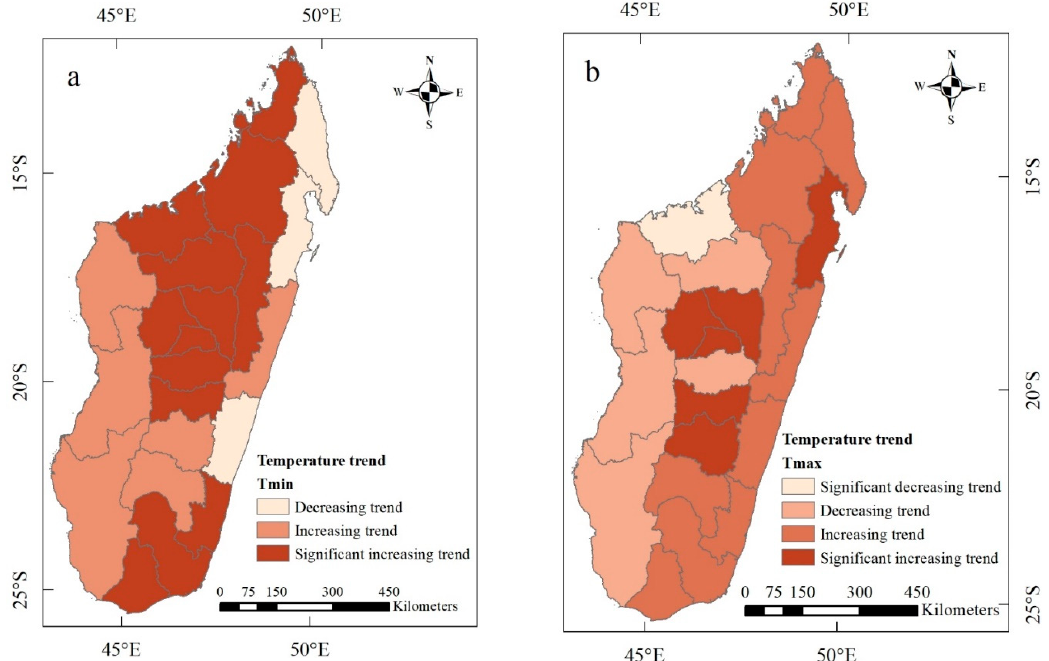
Figure 2. Annual ( a ) Tmin and ( b ) Tmax trend for each region of Madagascar.